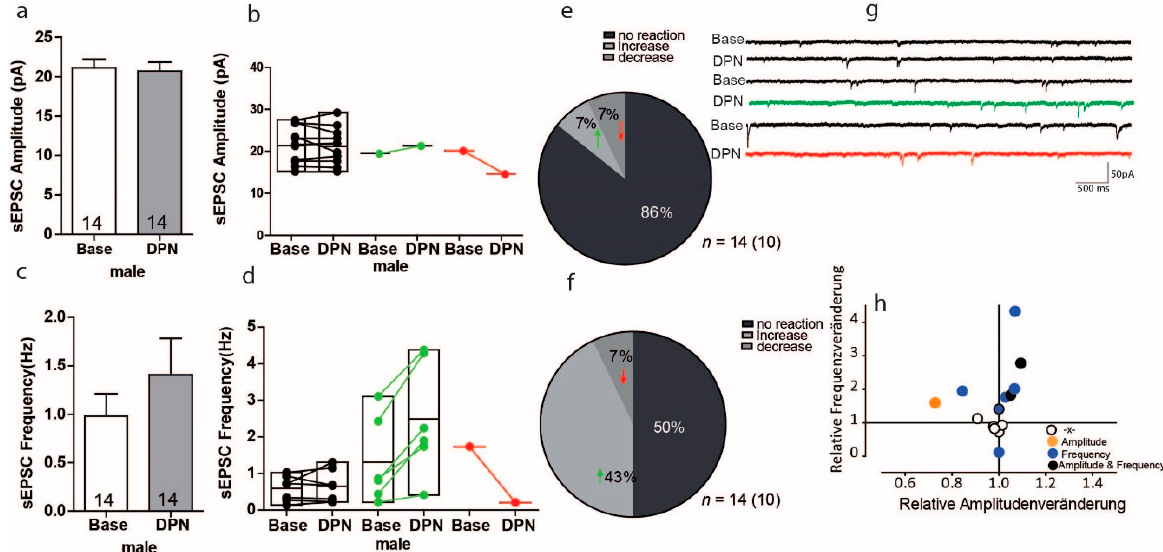
Figure 5. Activation of ERß on glutamatergic transmission in the PFC of male mice. ( a , c ) No significant changes in the average sIPSC amplitude and sEPSC frequency recordings were found during baseline and after DPN treatment. ( b , e ) Within-cell analyses show the majority of 14 cells had no significant response to DPN in sEPSC amplitude. ( d , f ) 6 of 14 cells showed a significant response to DPN treatment in sEPSC frequency. ( g ) Sample traces, frequencies and amplitudes of sEPSCs before and after DPN treatment. ( h ) No correlations were found between changes in sIPSC frequency and sIPSC amplitude.